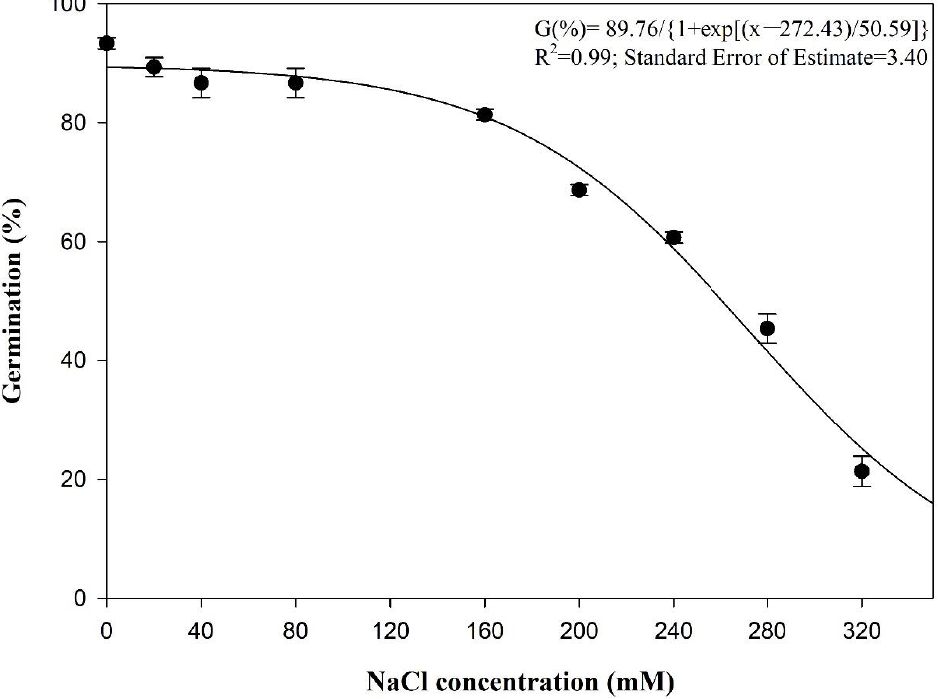
Figure 3. Effect of NaCl concentration on the germination of Vicia villosa seeds incubated at 20 °C under a 12/12-h dark/light photoperiod for 21 d. The vertical bars represent the standard error of the means.